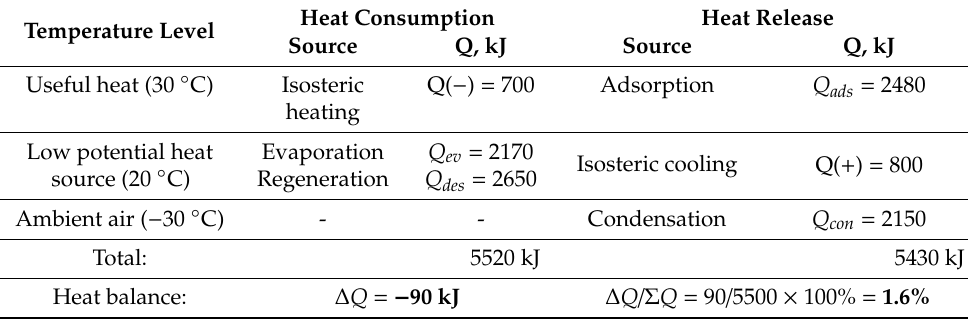
Figure 8. Evolution of inlet (black) and outlet (red) temperatures ( a ) and heat flow ( b ) for adsorber A1 over the course of a complete cycle, where t ads / des = 400 s. Stages I–VI are given in Table 1. Table 3. The cumulative heat effects and heat balance for 4 consecutive steady-state cycles at t ads / des = 400 s.